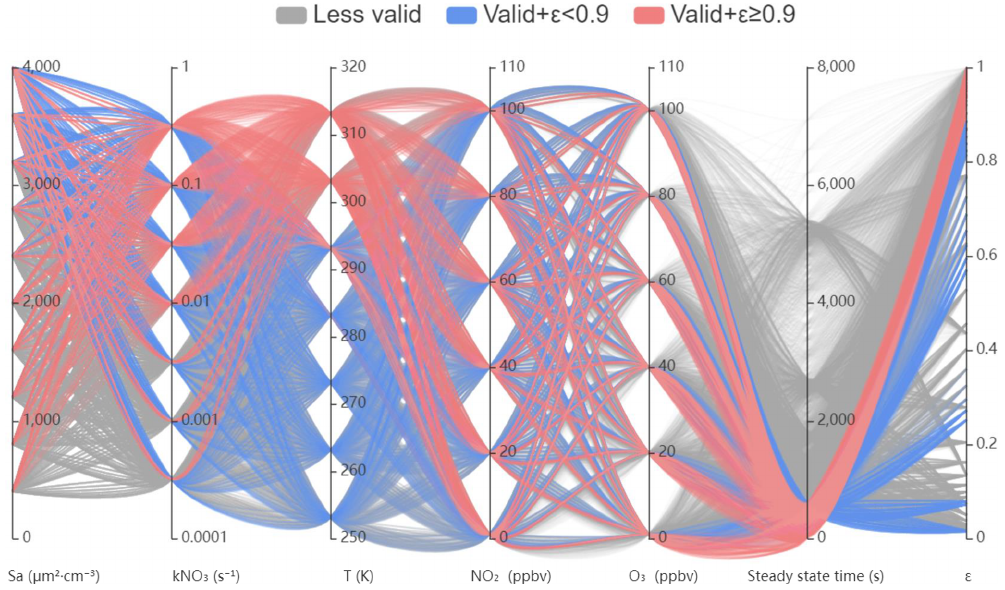
Figure 4. Numerical simulations for determining conditions available for the steady-state approximation method in a parallel-axis plot. Each line simply represents a simulation associated with different parameters in different vertical axes. The first five axes from the left represent initial variables used for constraining the simulations. The last two axes represent the time required for achieving steady state and the ε value calculated from the simulated results. The gray lines show cases approaching steady state for longer than 600s (less valid). The blue lines show cases approaching steady-state cases within 600s with ε less than 0.9, which is also inappropriate for steady-state analysis. The pink lines show cases approaching steady-state cases within 600s with ε higher than 0.9, which is suited for steady-state